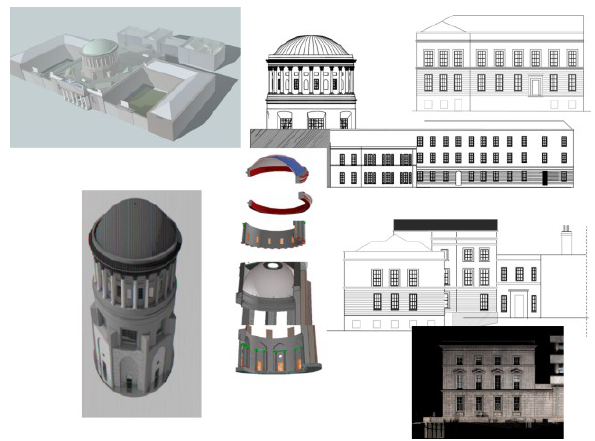
Figure 4: HBIM of Dublin Four Courts and sample conservation documentation automatically generated from the HBIM